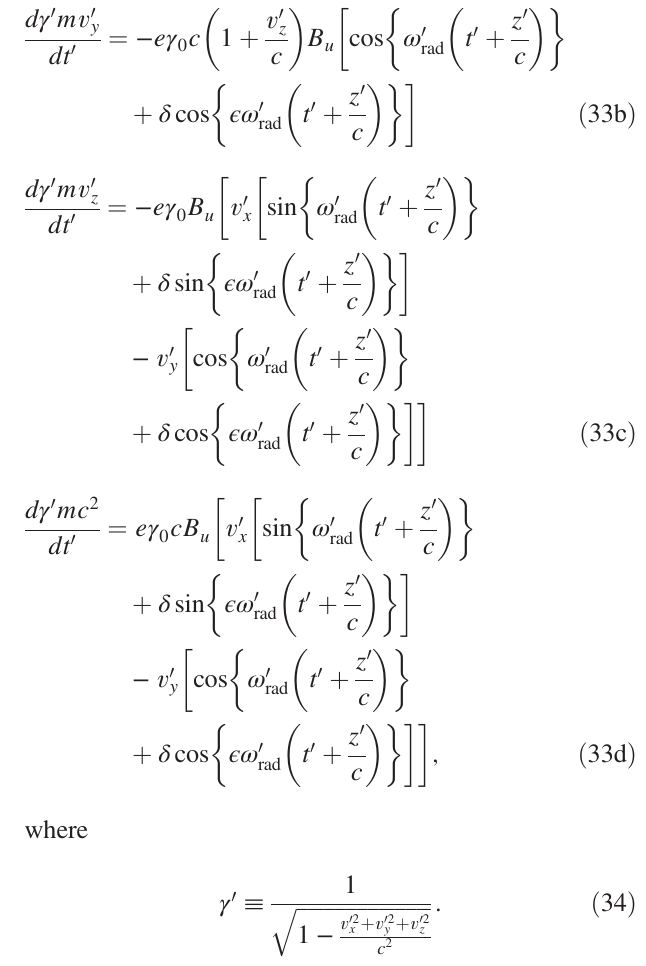
FIG. 5. Linear polarization: Far-field spectral energy density (energy/wavelength), as measured along the x ¼ y plane, for two different values of K . The electron energy is 60 MeV while λ u ¼ 1 . 39